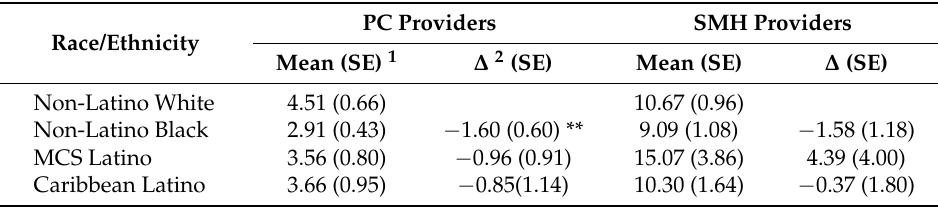
Table 5. Racial/Ethnic Differences in Number of Mental Health Visits by Type of